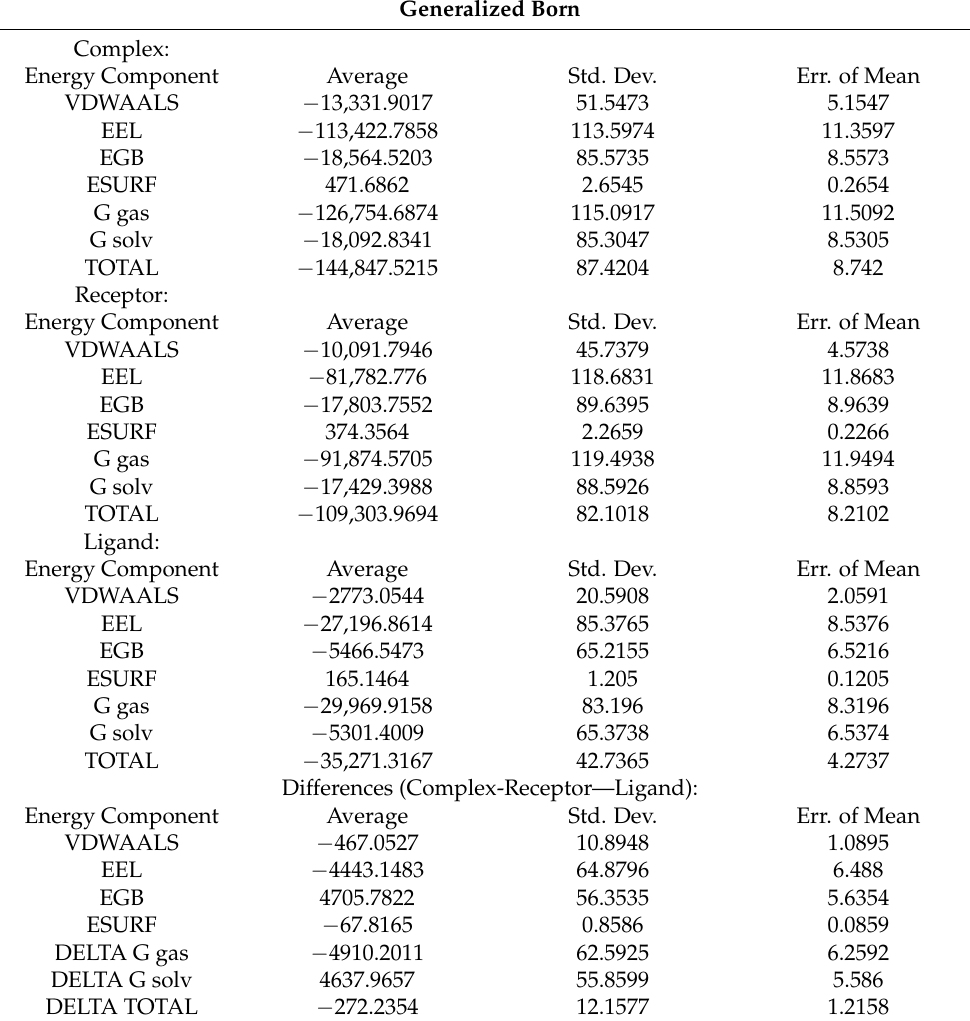
Table 5. Calculation of the generalized Born ESURF utilizing ‘LCPO’ surface areas. Each value is given in